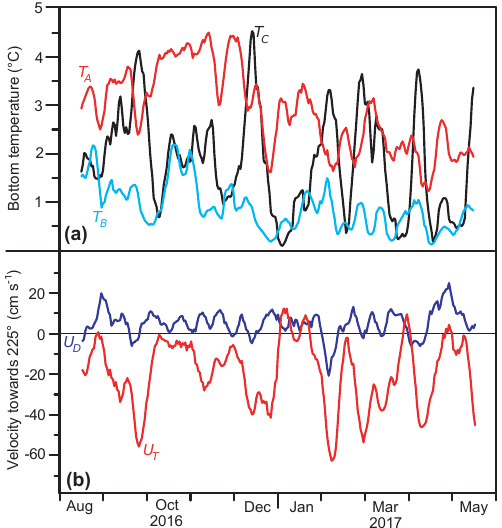
Figure 8. (a) Weekly averaged (7-day running mean) bottom tem- peratures at the three sites. (b) Weekly averaged velocity towards 225 ◦ at two depths at site B: deep velocity, U D , at 385m depth and top velocity, U T , at 135m depth.